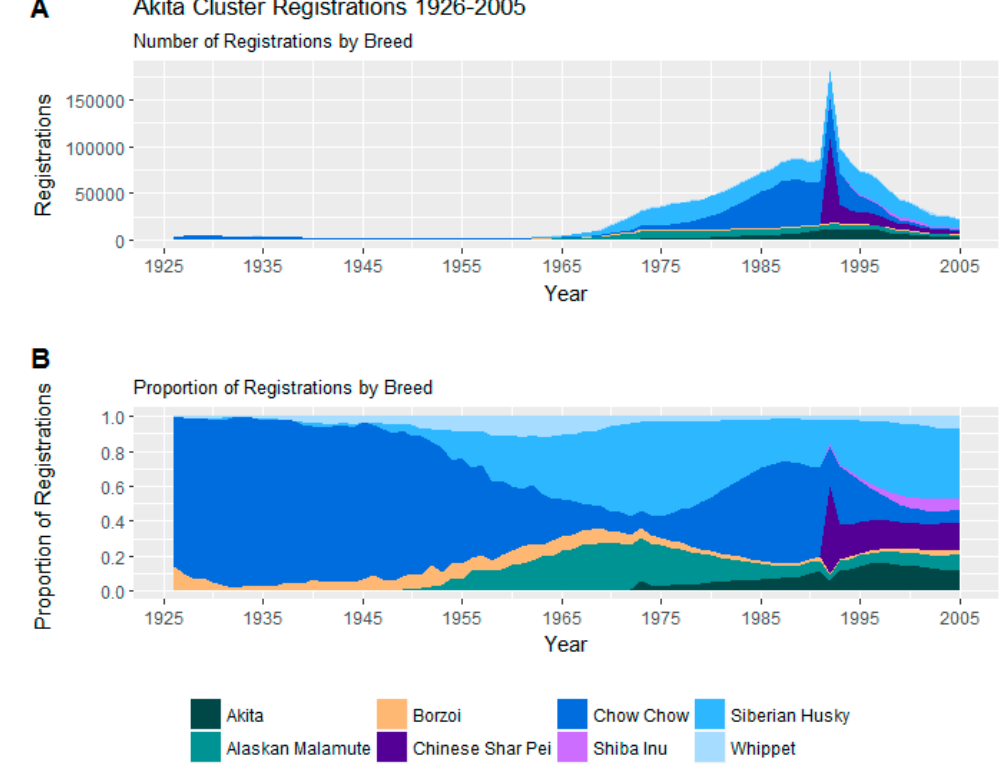
Figure 7. ( A ) Number of registrations; ( B ) and proportion of registrations within the Akita Cluster. The spike around 1992 reflects the rise of the Shiba Inus and Chinese Shar-Peis. When a new breed is first recognized by the AKC, there is an immediate spike in registrations because adult dogs are registered as well as new puppies. Because this cluster is relatively small, the spike is proportionately